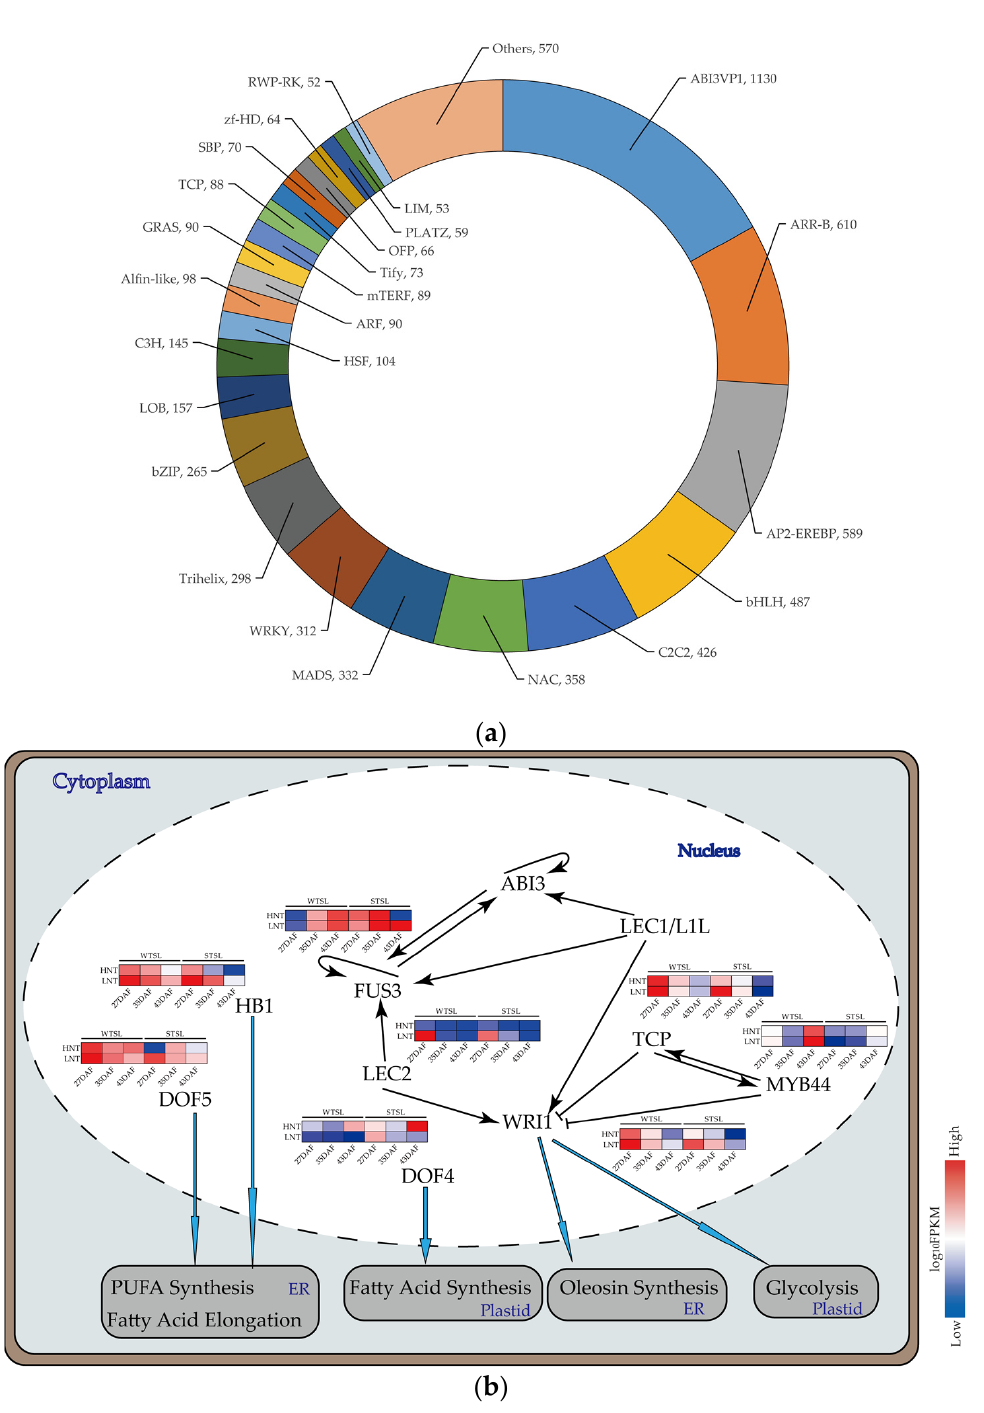
Figure 5. ( a ) Differentially expressed transcription factors (TFs) in different samples. ( b ) Pathways for involvement of TFs in B. napus seeds at different nighttime temperatures. ER represents endoplasmic reticulum.